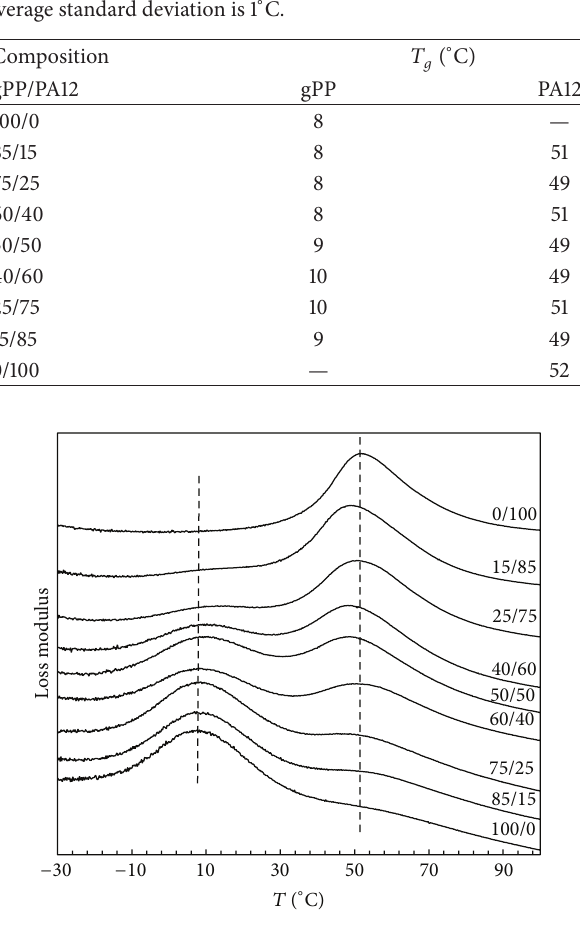
Figure 1: Loss modulus curves of the gPP/PA12 blends and the neat polymers.